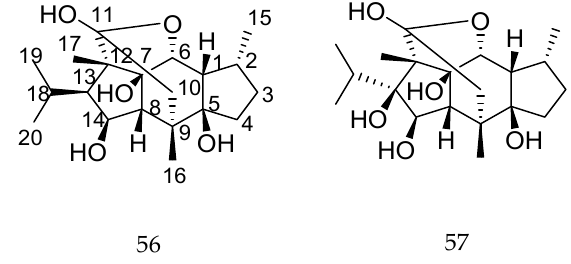
Figure 24. Chemical structures of diterpenes 56 and 57 [108].